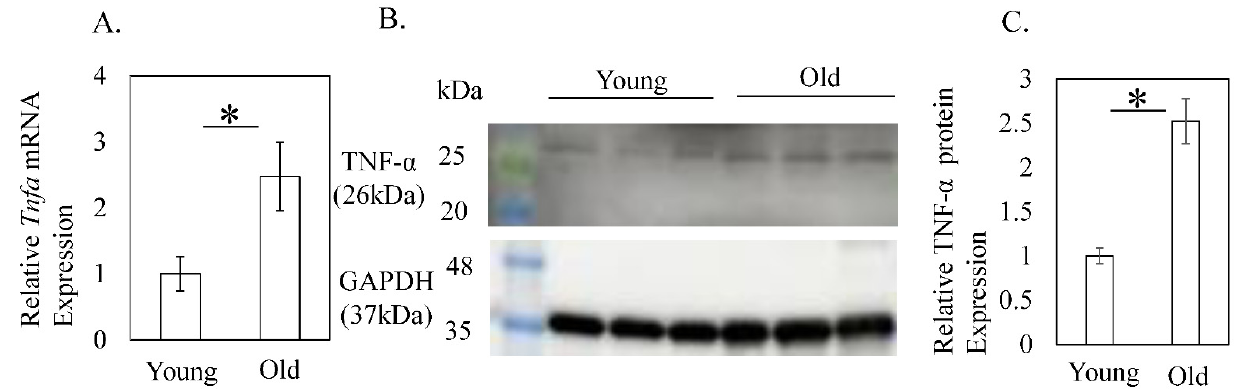
Figure 4. Tnfa mRNA and TNF- α protein expression in the quadriceps femoris. ( A ) Tnfa mRNA levels in young (3-month-old) and old (24-month-old) mice. ( B ) Image of a Western blot showing TNF- α protein expression relative to GAPDH at three (3M) and 24 months (24M). ( C ) TNF- α protein levels in the quadriceps femoris of young (3-month-old) and old (24-month-old) mice. Significant elevation of TNF- α mRNA and protein levels was found in the old group. Data are expressed as the mean ± standard deviation (SD). Asterisks indicate p <